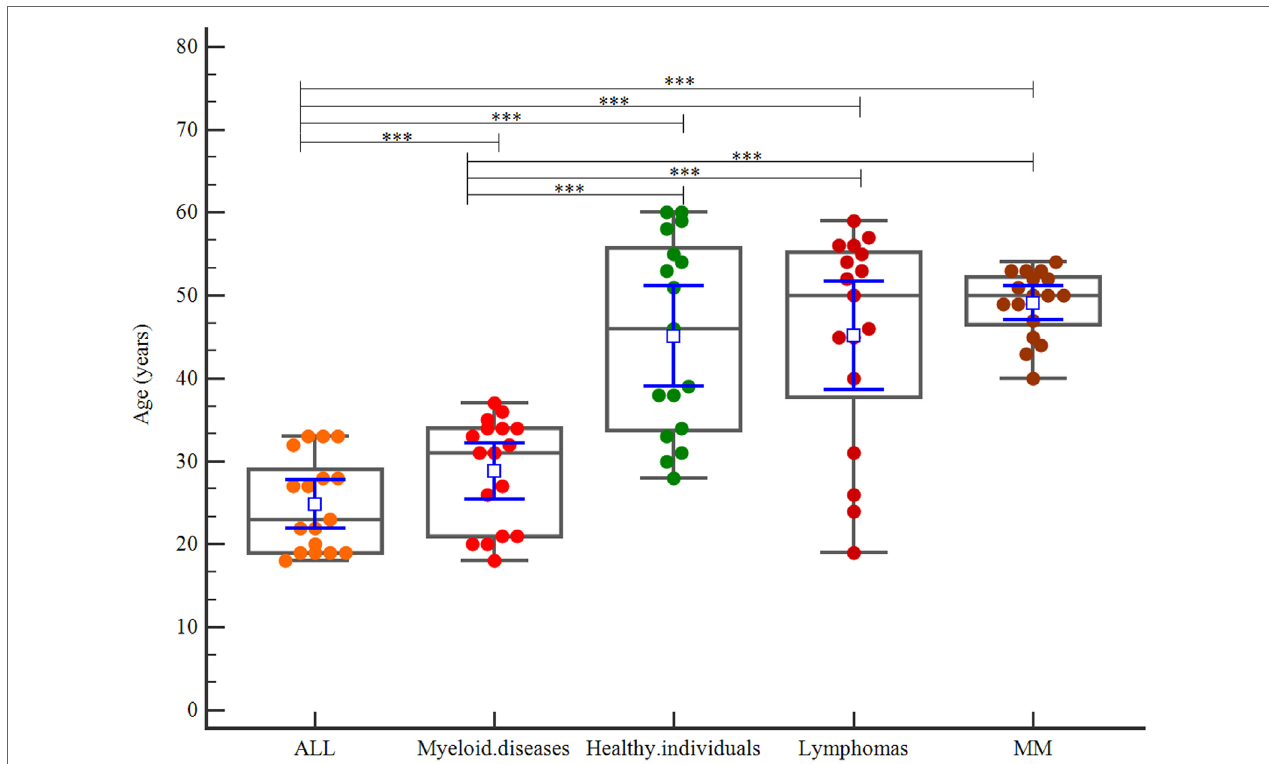
FigUre 6 | Correlation of age among patient disease subgroups and healthy